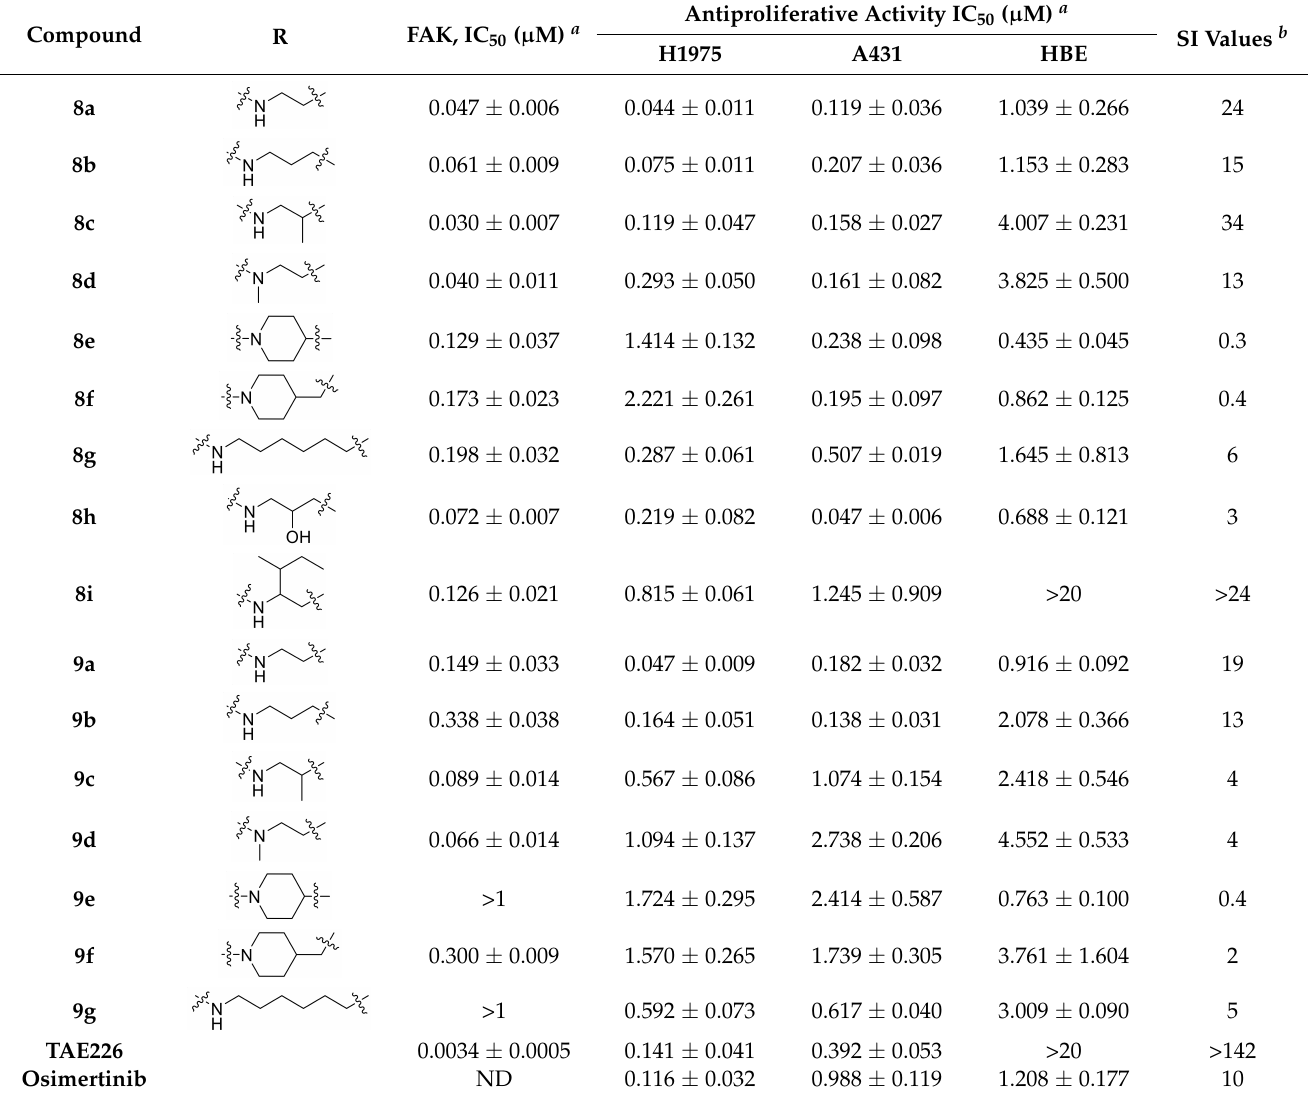
Table 1. Biological activities of compounds 8a – 8i and 9a – 9g